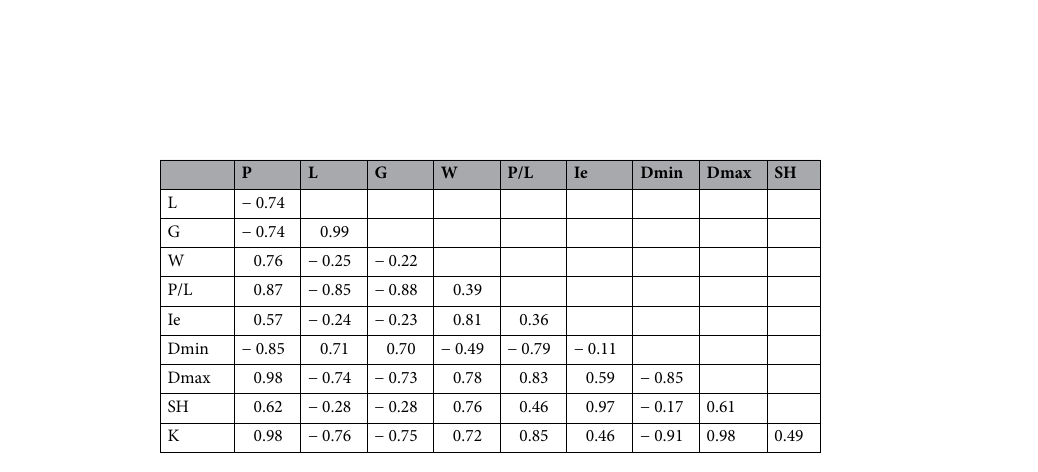
Table 2. Pearson correlation coefficients between the different alveograph parameters. All correlations were significant with a p -value <